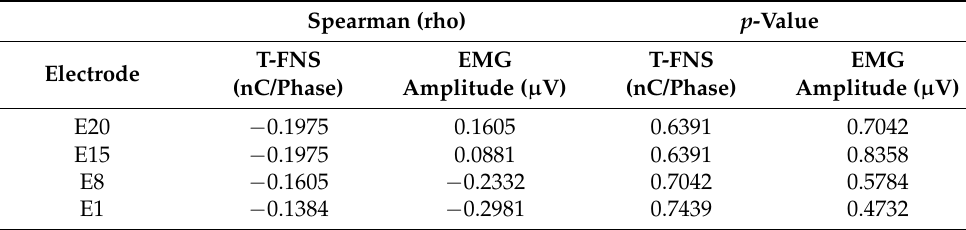
Figure 4. Example of electrodes placement estimation performed by Nautilus for the subject #S4 (EA7), who showed FNS responses with ST1 and ST2, in the electrode E1. Electrode 1 (basal) is extra-cochlear. * Blue circle and asterisks correspond to the labyrinthine segment of the facial nerve and Evo ® electrodes with closest electrode-nerve distances, respectively. Table 5. Relationship between cochlear-nerve distances and EMG responses of the